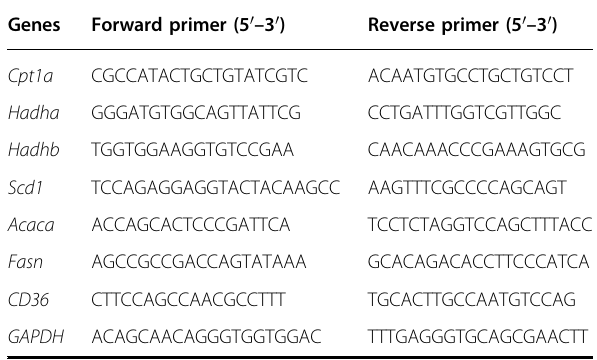
Table. 2 The sequences of the